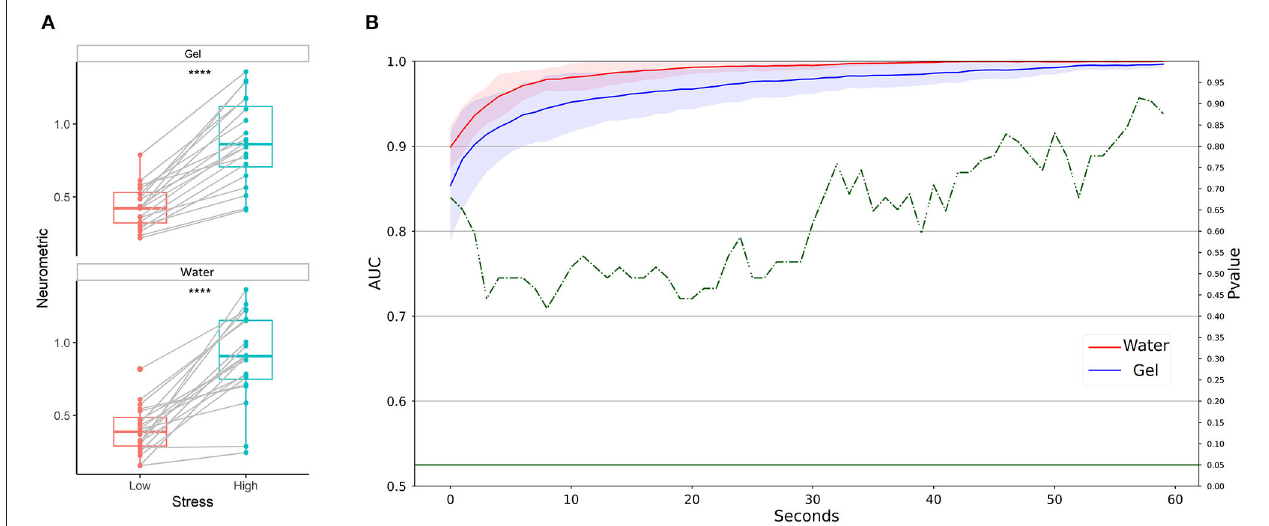
FIGURE 11 | Stress discrimination between low and high conditions in a realistic setting. (A) Statistical comparison has been performed for water-based and gel-based Neurometrics. The asterisks show the results of the Wilcoxon signed-rank test (**** p < 10 − 5 ). (B) AUC values obtained by water (in red) and gel (in blue) electrodes for different time resolutions (1–60s). The solid lines represent the median of the AUC among the participants. The shadows represent the mean absolute deviation of the AUC across participants. The dashed green line represents the results in terms of p -values of the Wilcoxon signed-rank test. The threshold of significance ( p = 0.05) has been highlighted in the same